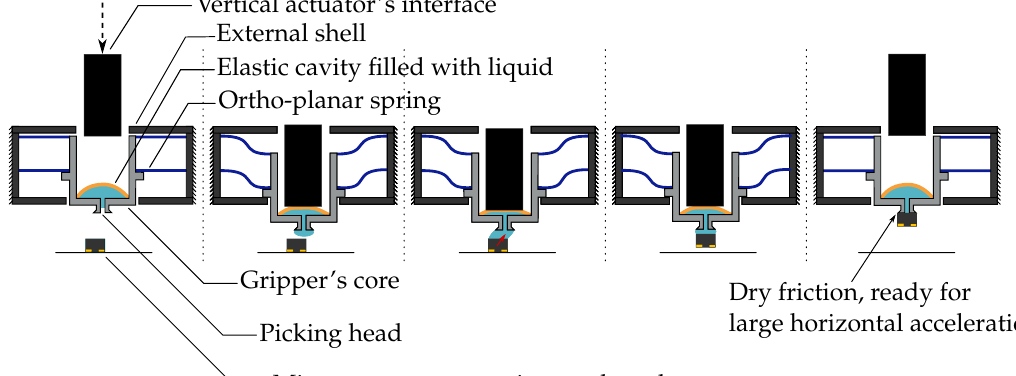
Figure 1. Schematic overview of the passive capillary gripper. The gripper and its guided interface can be mounted in a pick-and-place machine. By applying pressure with the vertical actuator on the interface, the gripper is moved downwards. The latter is guided by two ortho-planar springs in parallel. The stiff cavity holds the load of the interface and transmits it to the two springs, which deflect. Once the stops are reached, the cavity deflects, which generates a droplet used to pick the component. The volume of the droplet can be controlled by changing the pressure applied by the pick-and-place machine’s vertical